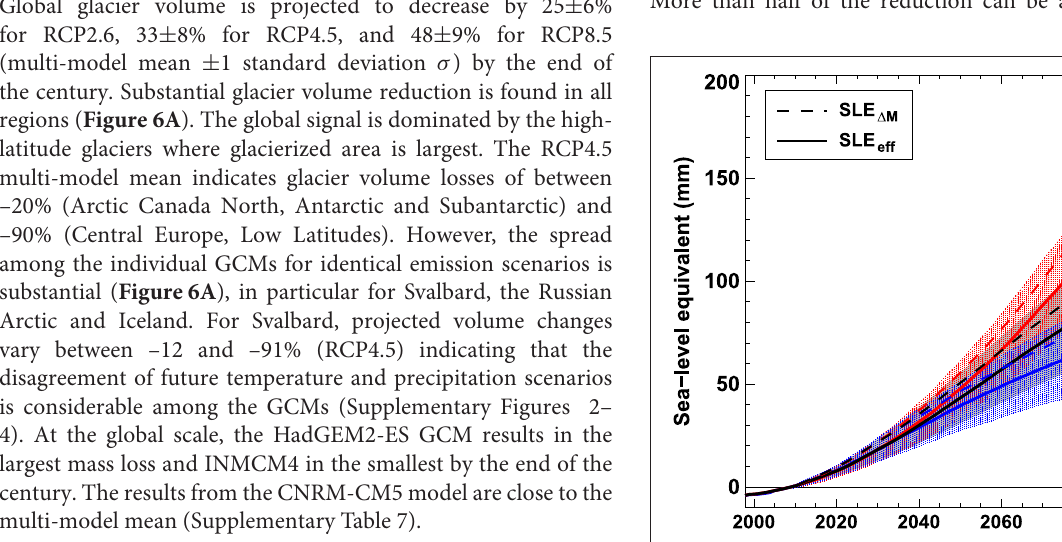
FIGURE 7 | Multi-model means of projected cumulative global sea-level equivalent from glacier net mass loss relative to 2010 neglecting (SLE 1 M ) and accounting (SLE eff ) for the effect of ice displacing ocean water using three RCPs. The shading indicates ± 1 σ for SLE eff from the 14 GCMs. Crosses show SLE eff by 2100 for each GCM run; filled circles refer to multi-model means.